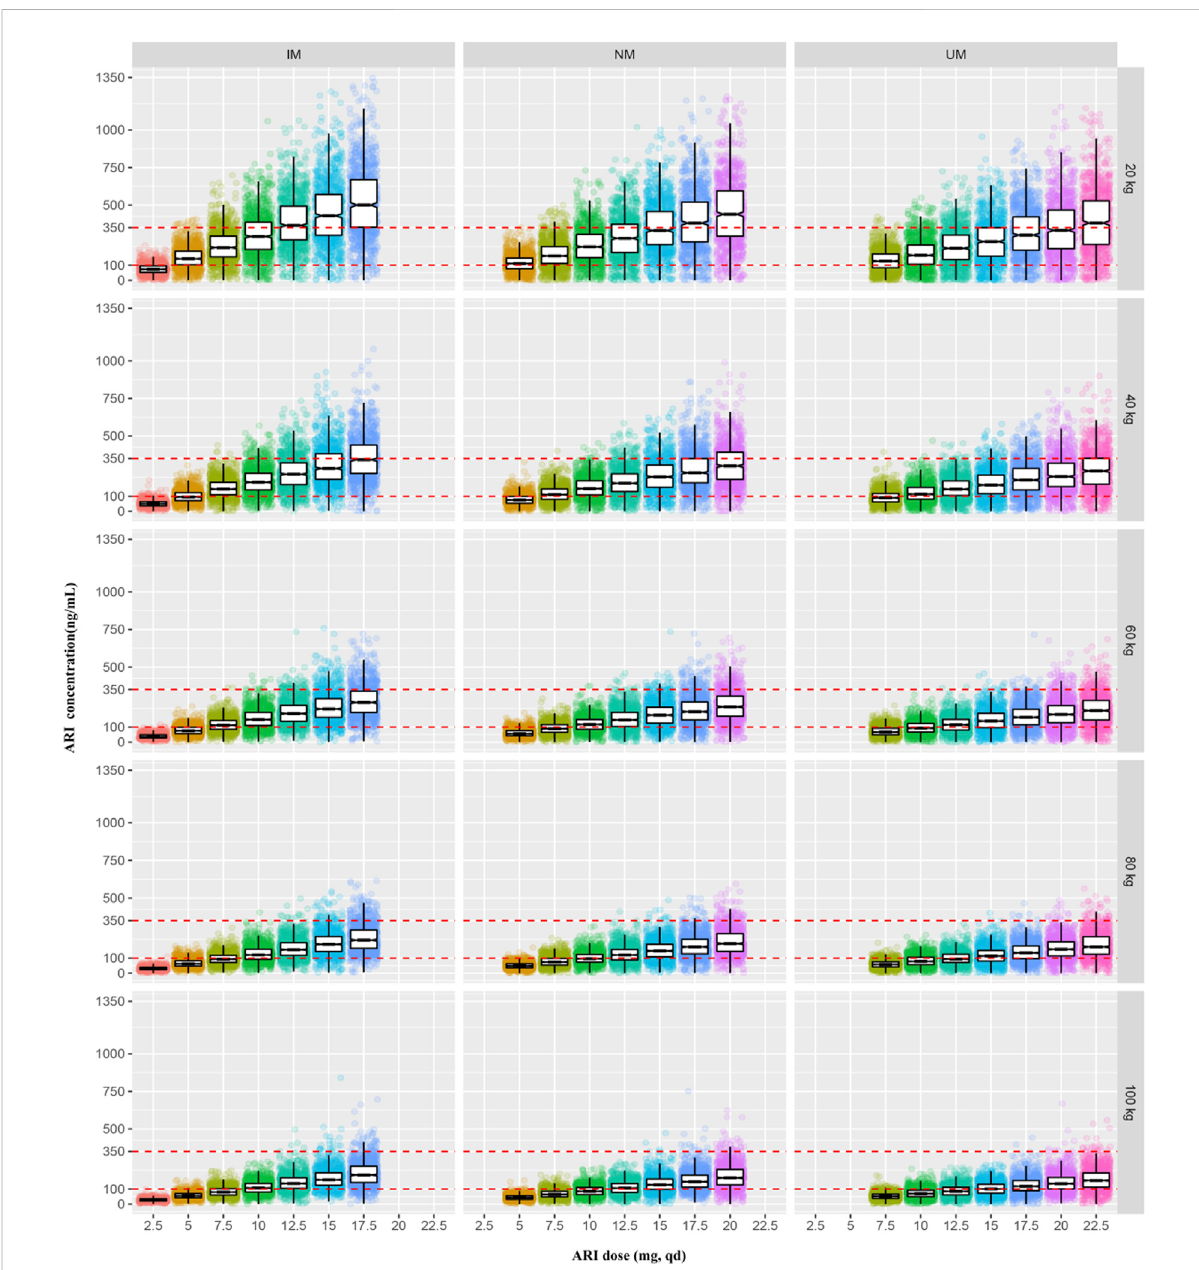
FIGURE 7 The simulated steady-state trough concentrations of ARI for patients with different body weight and CYP2D6 genotypes under the different dosage